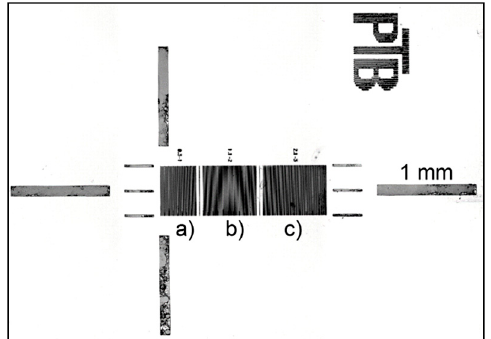
Figure 11. Tip-testing standard TPN 1 with three measurement areas corresponding to the different groove width ranges of a) 0.3 µm to 1.0 µm, b) 1.1 µm to 2.0 µm, and c) 2.1 µm to 3.0 µm.